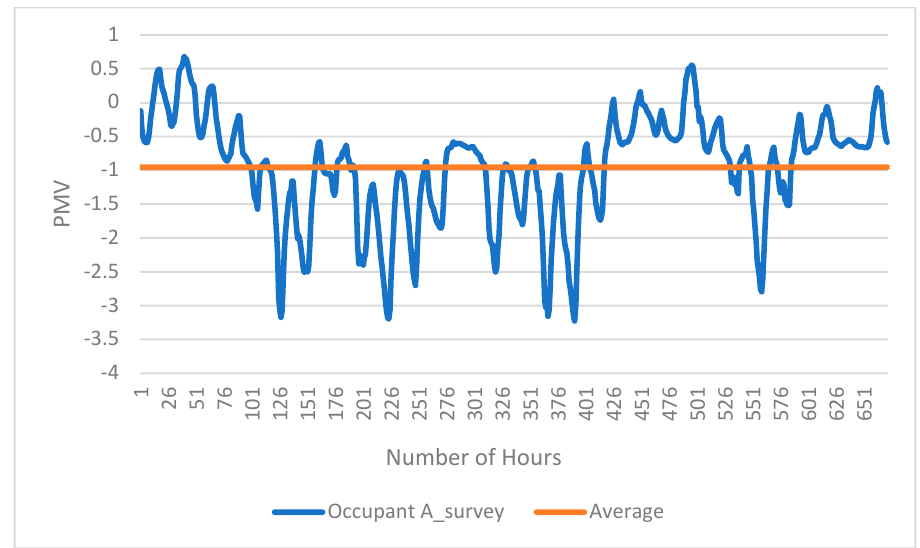
Figure 10. PMV fluctuation for occupant A in survey–based simulation scenario.